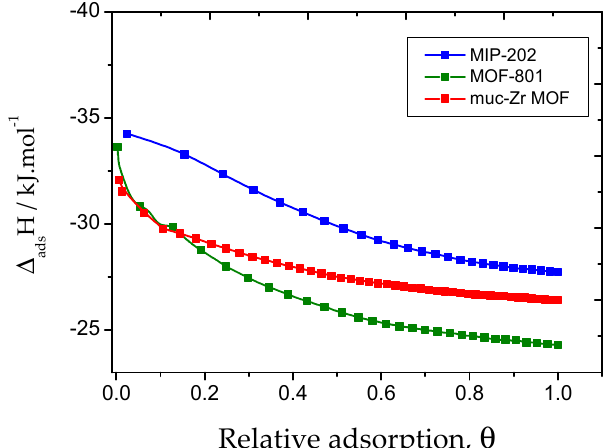
Figure 8. Isosteric heat of adsorption of CO 2 by the three MOFs obtained at temperatures of 273 K and 298 K.